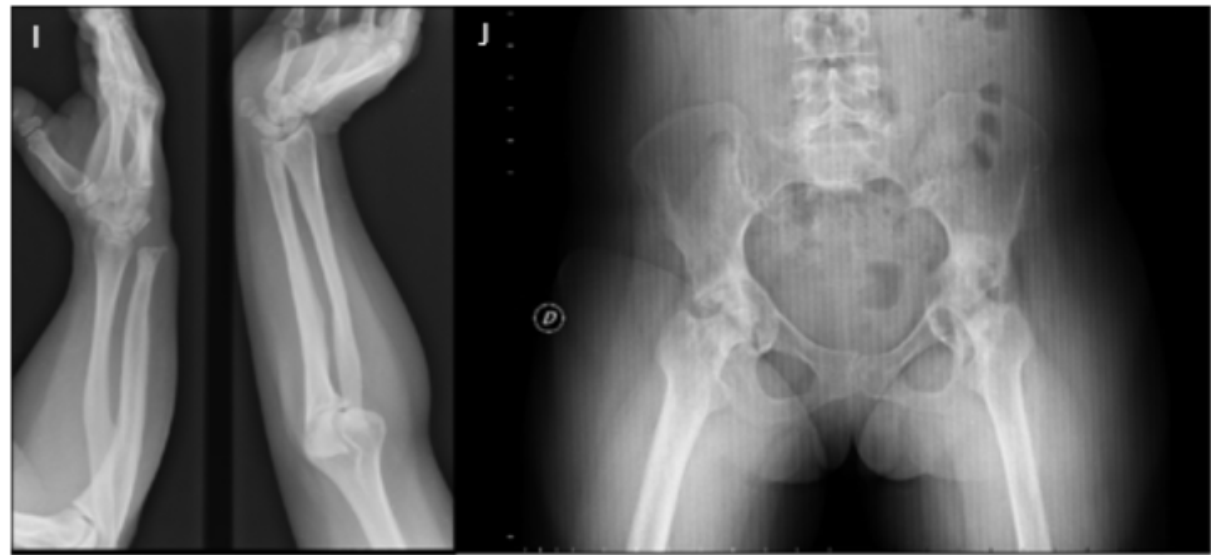
Figure 3. Radiologic controls. Phenotypic progression. ( A ) Radiological control hands in 2008. ( B ) Radiological control hands in 2011. ( C ) Radiological control hands in 2014. ( D ) Photography hands in 2021. ( E ) Serpentine fibula in 2002. ( F ) Photography legs in 2021. ( G ) Radiological control feet in 2014. ( H ) Photography feet in 2021. ( I ) Radiological control forearm in 2016. ( J ) Anteroposterior radiological control of the hip in 2013.